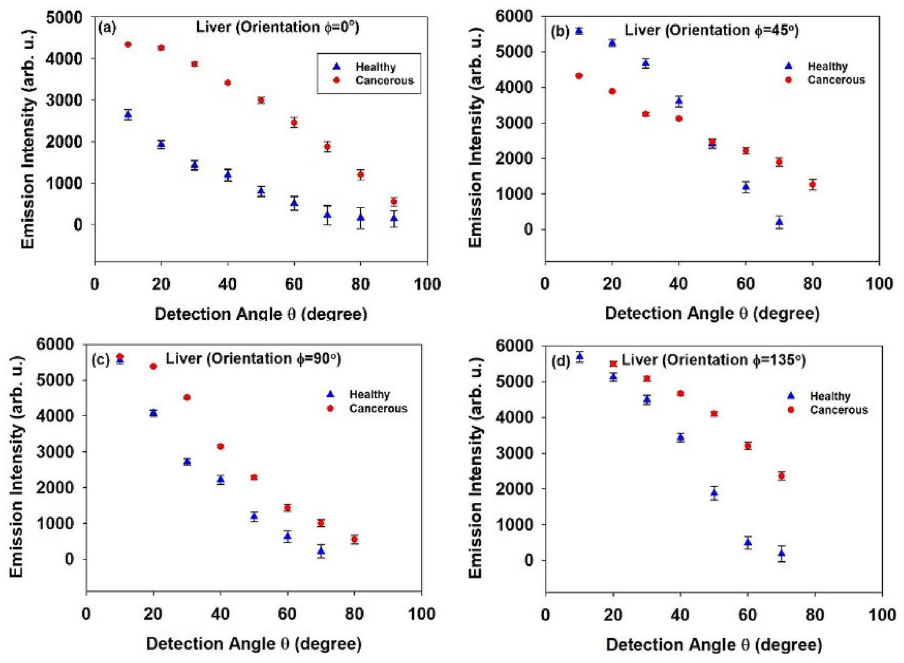
Figure 6. Intensity of the LIF emission in terms of detection angle for two healthy and cancerous Liver tissues at different orientations: ( a ) φ = 0°, ( b ) φ = 45°, ( c ) φ = 90°, and ( d ) φ = 135°.